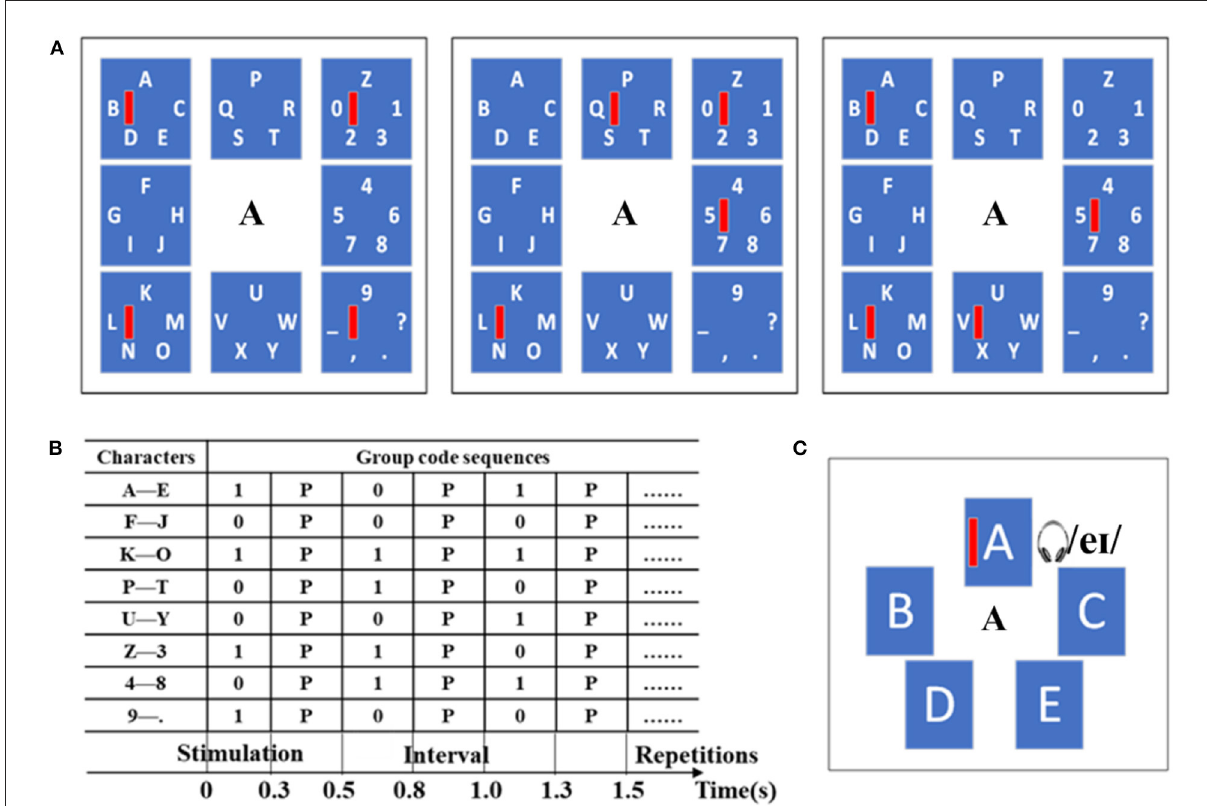
FIGURE1 Speller paradigm example. (A) The first stage paradigm includes 3 sub-trials motion-onset stimuli based on the SDMA scheme. (B) A list of group code sequences for the first stage. (C) One example of the second stage paradigm includes motion-onset stimuli and pronunciation of character A